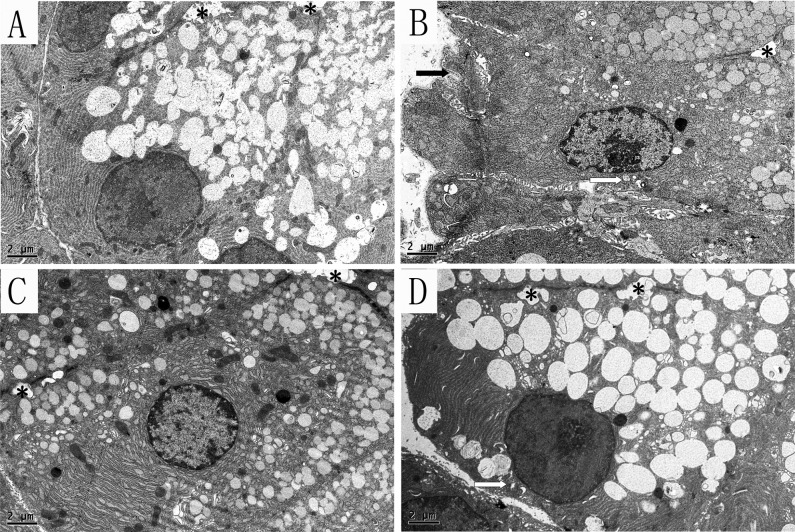
The acinar cells in the lacrimal gland.A, SHAM; B, OVX; C, OVX + E; D, OVX + iCR. All scale bars represent 2 μm. * stand for the lumen. The white arrows indicate the mitochondria lesion, and the black arrow represents the cell membrane sag. Compared with the SHAM group (Fig. 5, A), the endoplasmic reticulum was diluted and arranged in a disorderly fashion in the OVX groups. Most of the mitochondria appeared to be swollen, with dissolution and crest fracture. Moreover, the diameter of the white secretory granules seemed decreased obviously. The cell shrink, with sag on the membrane and an increased intercellular space, was often seen (Fig. 5, B). Estrogen treatment did not ameliorate the enlargement of endoplasmic reticulum, but the mitochondria seemed normal—ridge fracture was rarely seen. Similar to OVX group, the diameter of the secretory granules decreased also, but the extent of cell shrink was more slightly (Fig. 5, C). Interestingly, the iCR therapy was shown to ameliorate the expansion of endoplasmic reticulum, but not the mitochondria lesions. The diameter of the secretory granules was analogous to SHAM group, and the cell atrophy was rarely observed (Fig. 5, D).